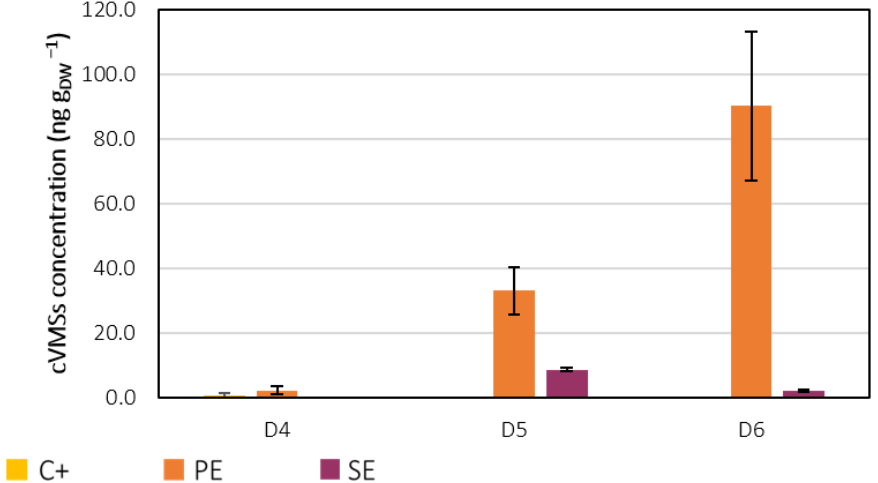
Figure 9. D4, D5 and D6 concentration in the lyophilised biomass samples collected from cultures C+, PE and SE.